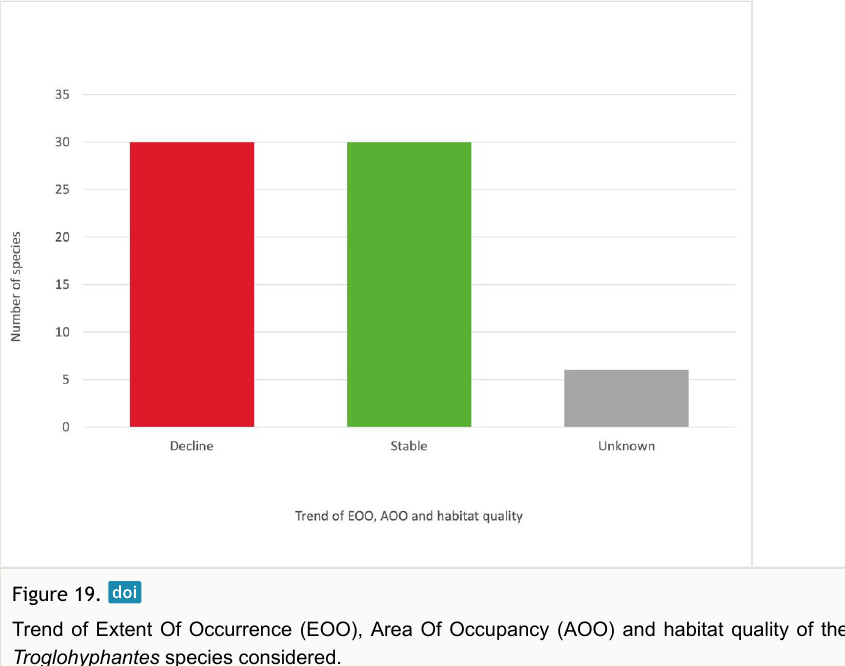
Figure 19. Trend of Extent Of Occurrence (EOO), Area Of Occupancy (AOO) and habitat quality of the Troglohyphantes species